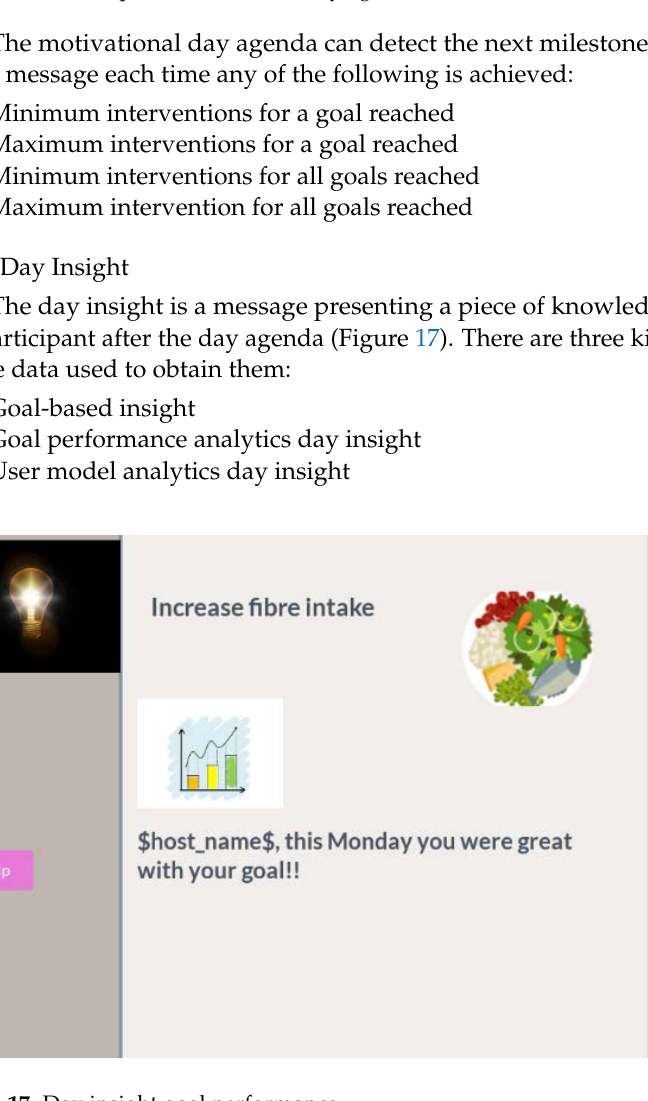
Figure 16. Mock-up for motivational day agenda.